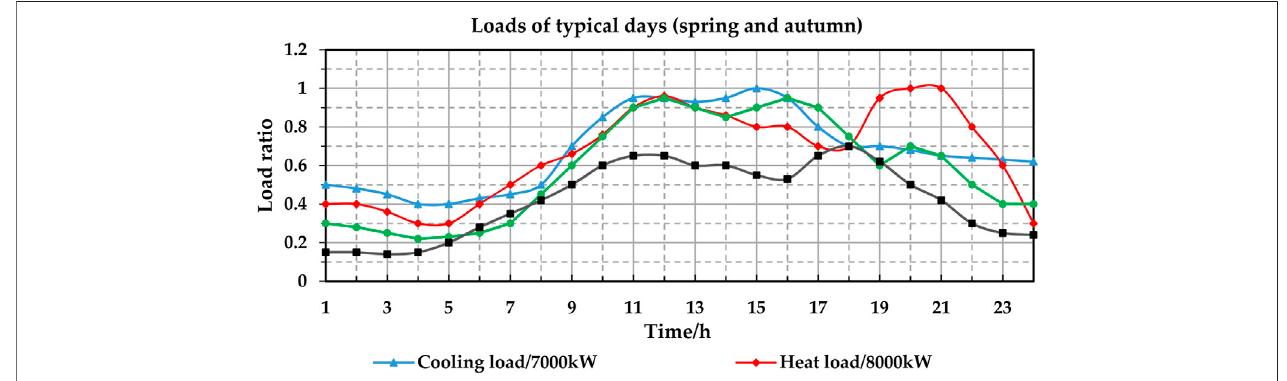
FIGURE 5 | Representative daily load curve in spring and autumn.